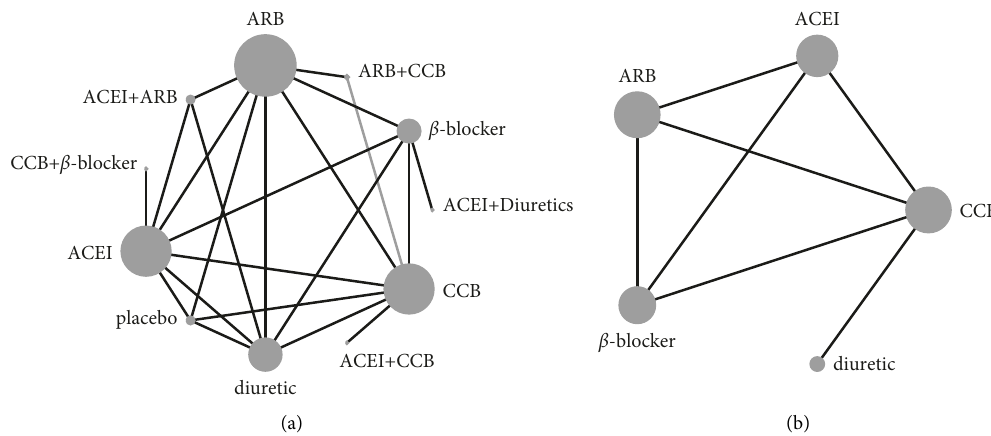
Figure 4: The construction of the network. (a) Flow-mediated dilation, (b) brachial artery diameter) ACEI: angiotensin-converting enzyme inhibitors, ARB: angiotensin receptor blocker, CCB: calcium channel